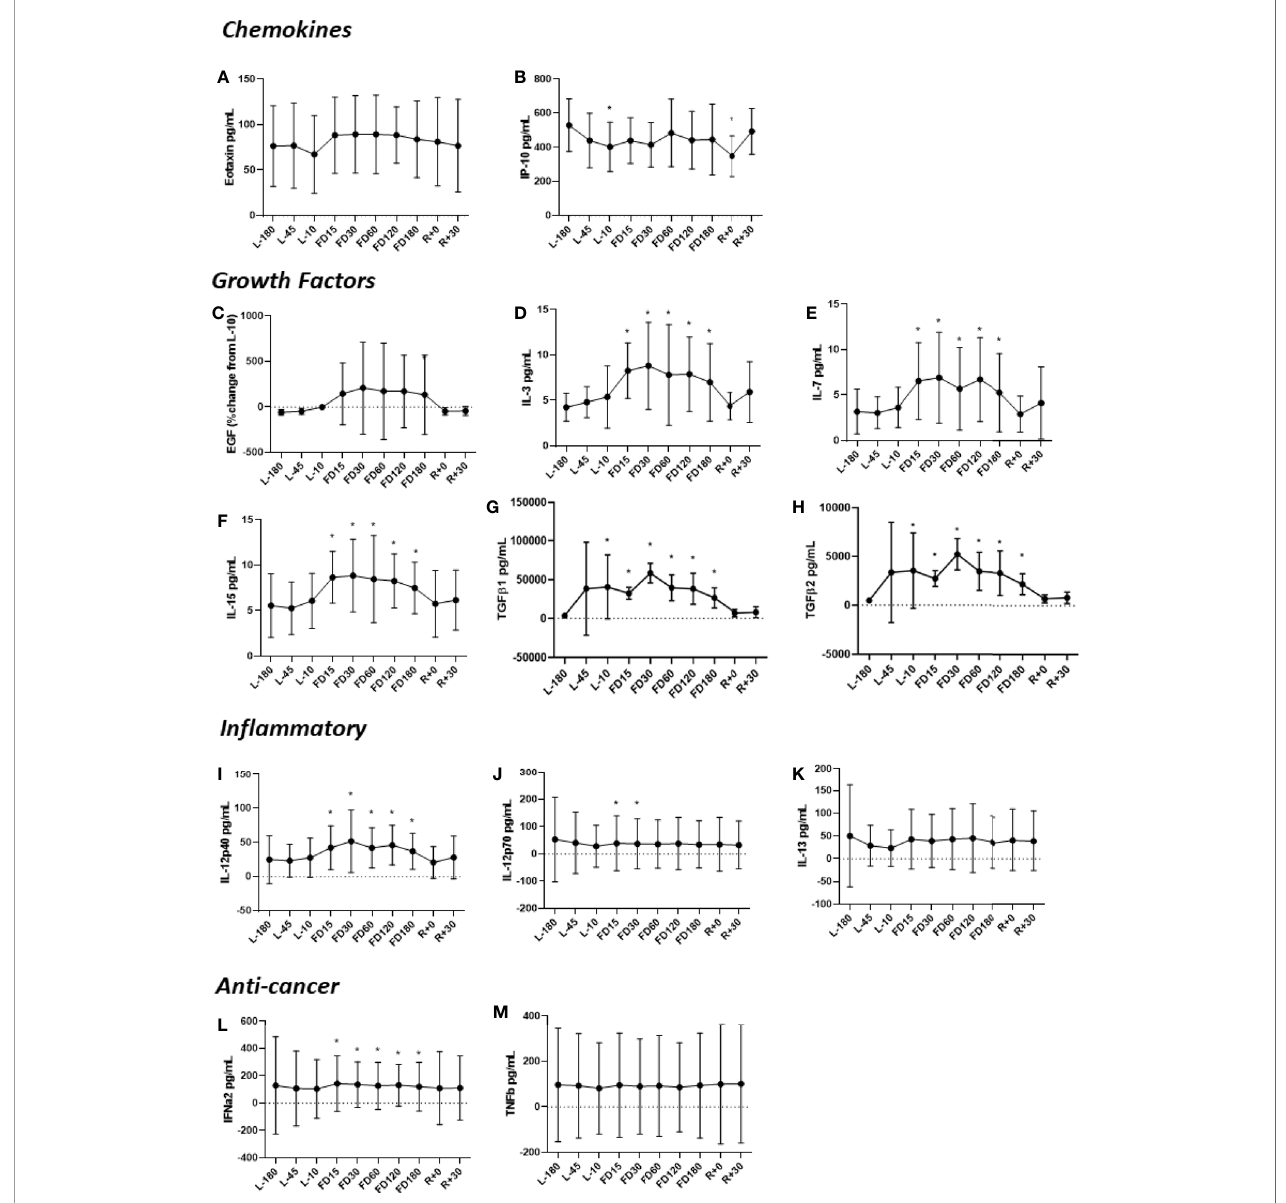
FIGURE 1 | Concentrations of plasma (A) Eotaxin, (B) IP-10, (C) EGF, (D) IL-3, (E) IL-7, (F) IL-15, (G) TGF b 1, (H) TGF b 2, (I) IL-12p40, (J) IL-12p70, (K) IL-13, (L) IFN a 2 and (M) TNF b before, during and after space fl ight. The TGF b assessments (G, H) represent quantitation of the active form of the molecule. Data are mean ± SD. Signi fi cance was evaluated via a Student ’ s t test by comparing all other data points to L-180 baseline data. Signi fi cant differences (P ≤ 0.05) are indicated